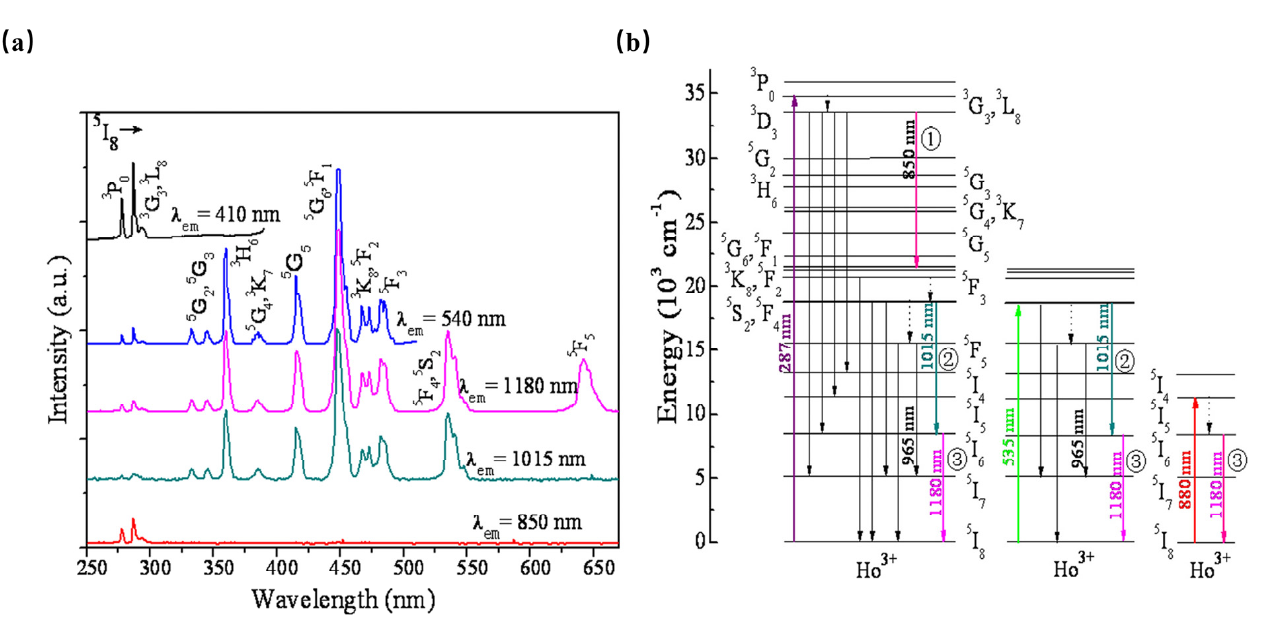
Figure 6. ( a ) PLE spectra monitored at various PL wavelengths of β -NaYF 4 :Ho 3+ phosphor. ( b ) Schematic energy-level diagram for Ho 3+ showing the concept of sequential three-step NIR-QS under excitation of 287, 535, and 808 nm, respectively.